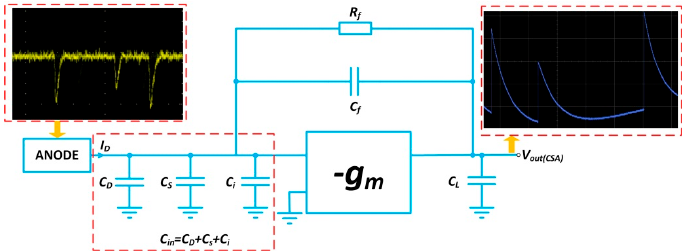
Figure 6. Schematic drawing of the CSA. The oscillogram in the red dotted box at the top left shows several narrow pulses of input current and long-tail pulses with a duration of R f C f in the red dotted box at the top